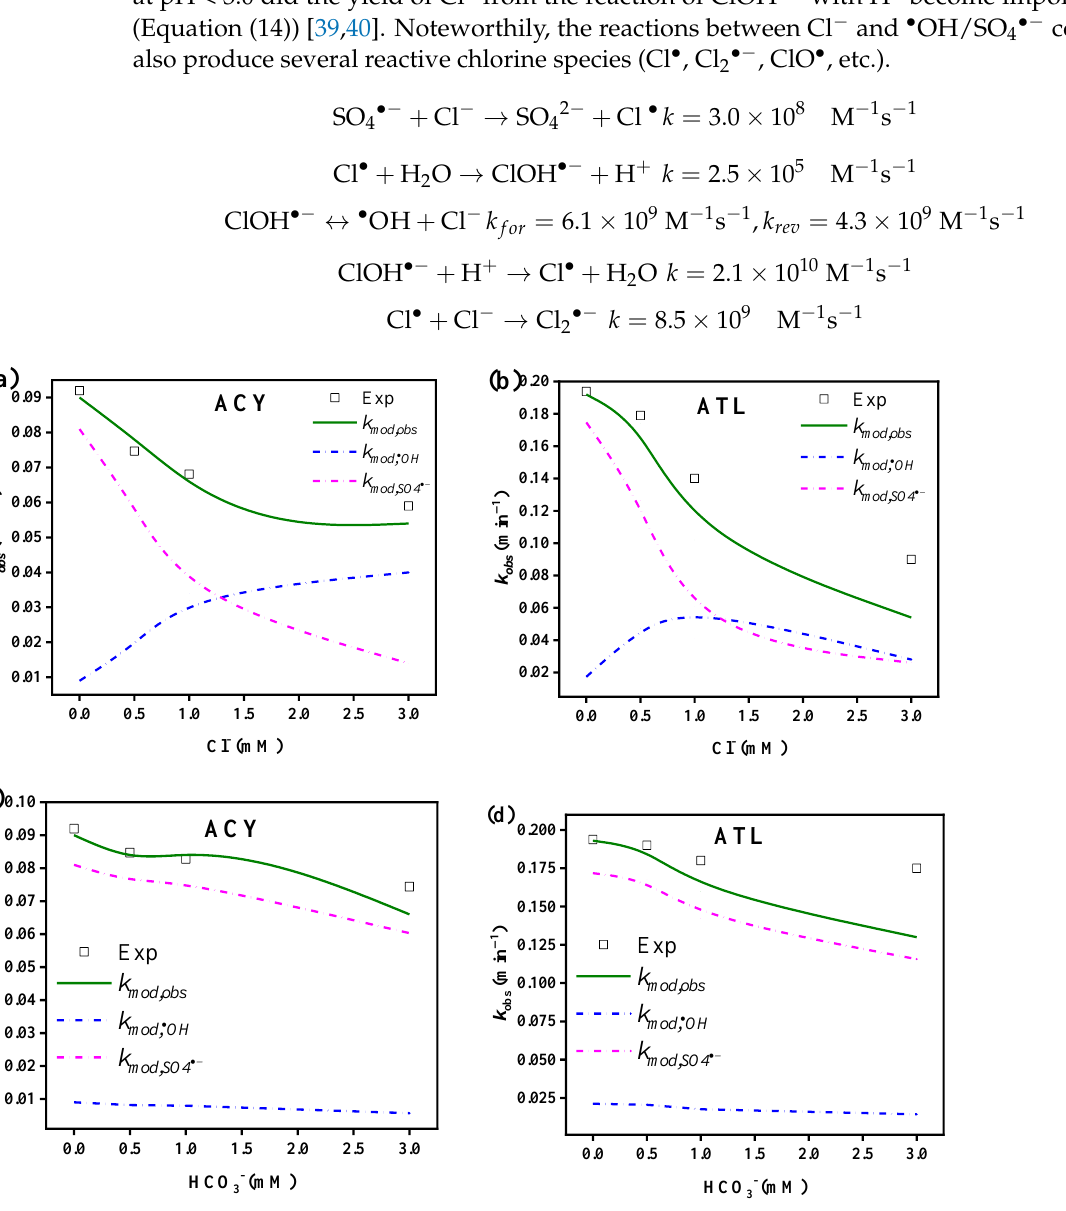
Figure 5. Effects of Cl − and HCO 3 − dosages on the k obs of ACY ( a , c ) and ATL ( b , d ) degradation and specific rates of • OH and SO 4 •− in UV/PDS process. Conditions: [ACY] 0 = 0.022 mM, [ATL] 0 = 0.019mM, [PDS] 0 = 0.6 mM, pH =